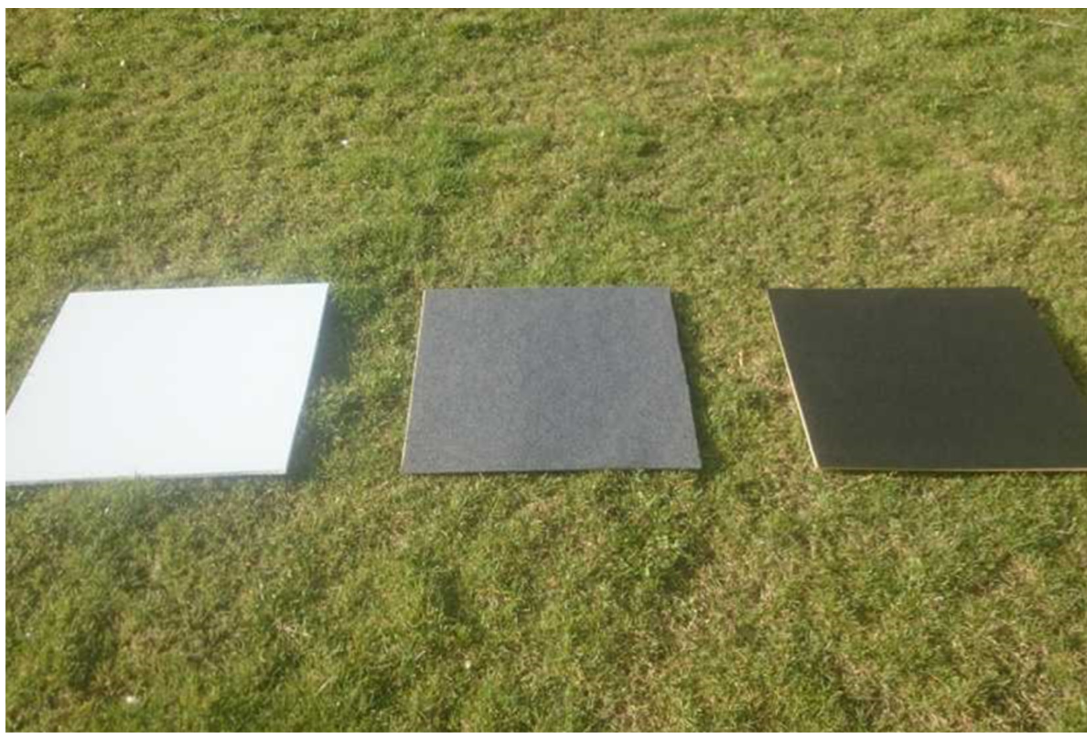
Figure 9. Templates for reflectance calibration, (Image from MosaicMill). In this process, a 3D matrix of the emissivities of the template at each wavelength, as well as the average emissivity for template tonalities, were obtained [36,37]. It is also obtained the relationship between the camera digital number DN λ and the reflectance percentage of each template tonalities (being 0% for the black and 100% for the white